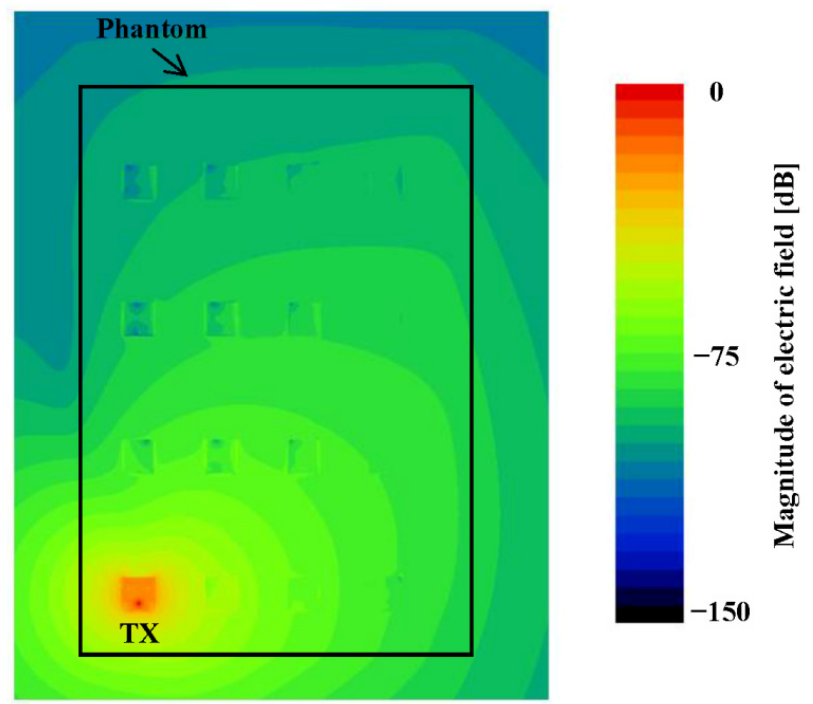
Figure 8. Normalized electric field distribution at 10